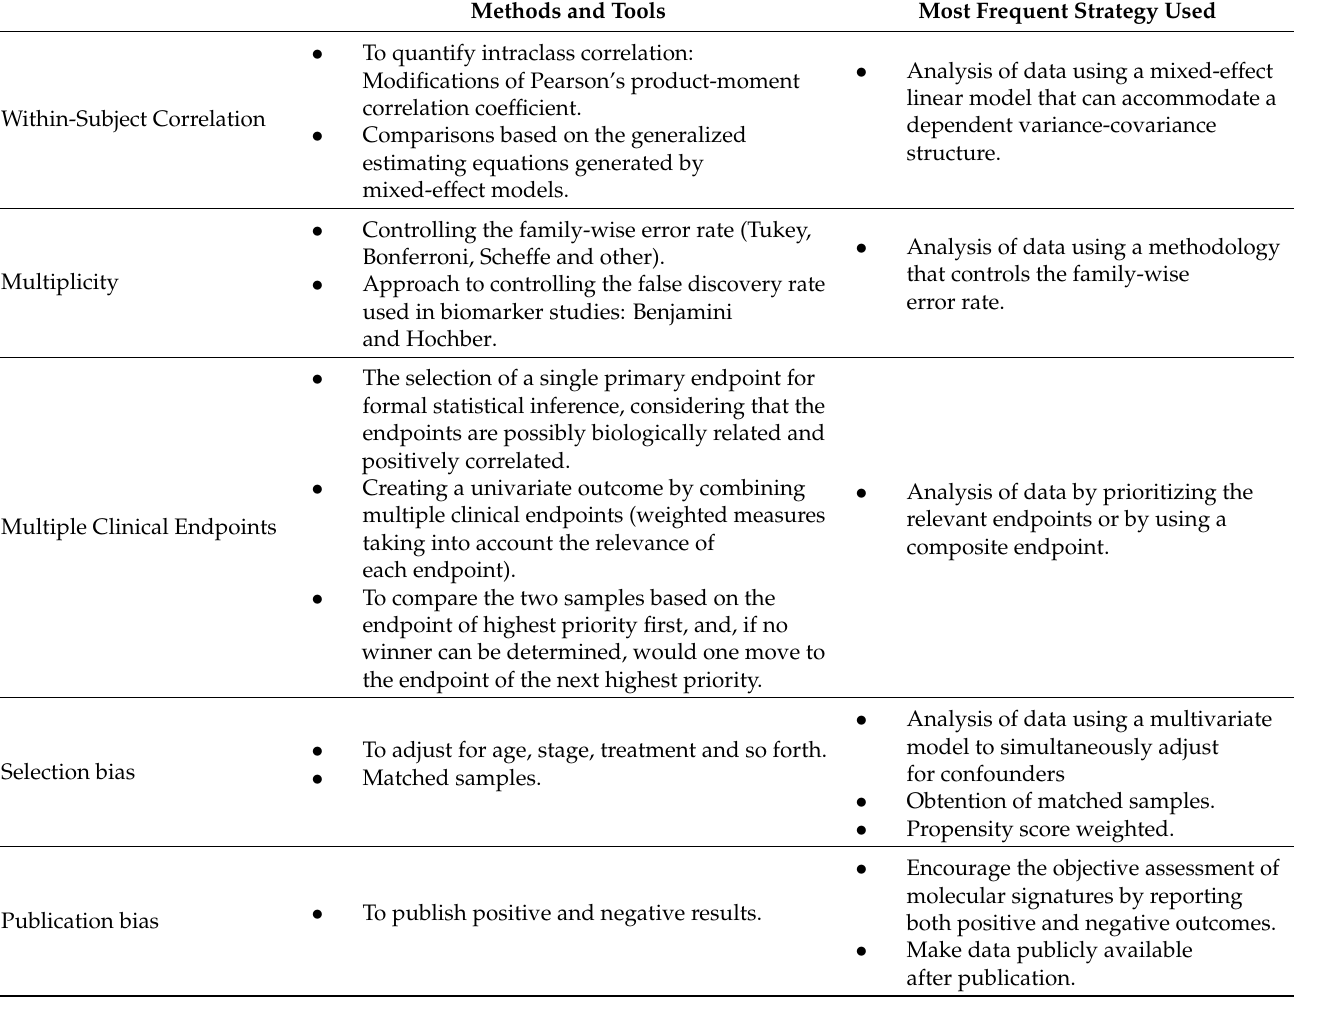
Table 2. A summary of methods, tools and strategies proposed to avoid different types of bias. Methods and